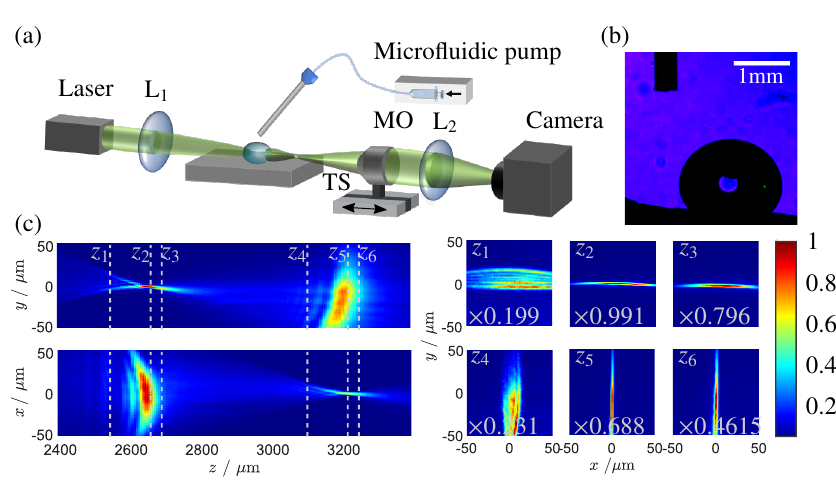
Figure 1. (a) Sketch of the experimental setup used to detect the 3D light landscape refracted by a droplet on a liquid-repelling surface (Taro leaf). A linearly polarized Gaussian beam is focused by the first lens ( L 1 ) into the droplet. The refracted light is imaged by a microscope objective (MO) mounted on a translation stage (TS) and a lens L 2 onto a camera. (b) Droplet on a leaf (camera image, blue LED illumination). A needle (0.4 mm diameter) is shown in the left upper corner. (c) Experimentally measured intensity landscape behind the droplet. z = 0 is set to the middle of the droplet. Shown transverse distributions are normalized to the maximum per plane for z -positions z i = {2550, 2660, 2690, 3100, 3210, 3240} µ m, j = [1, 6]. Adapted from [1], licensed under a Creative Commons Attribution 4.0